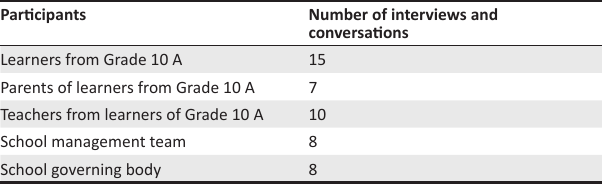
TABLE 1: Participants and the interviews and conversations that were conducted. Participants Number of interviews and